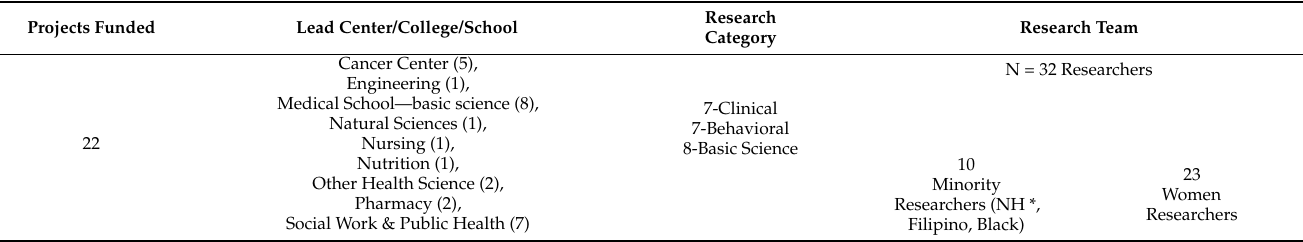
Table 1. Characteristics of Funded Pilot Projects.